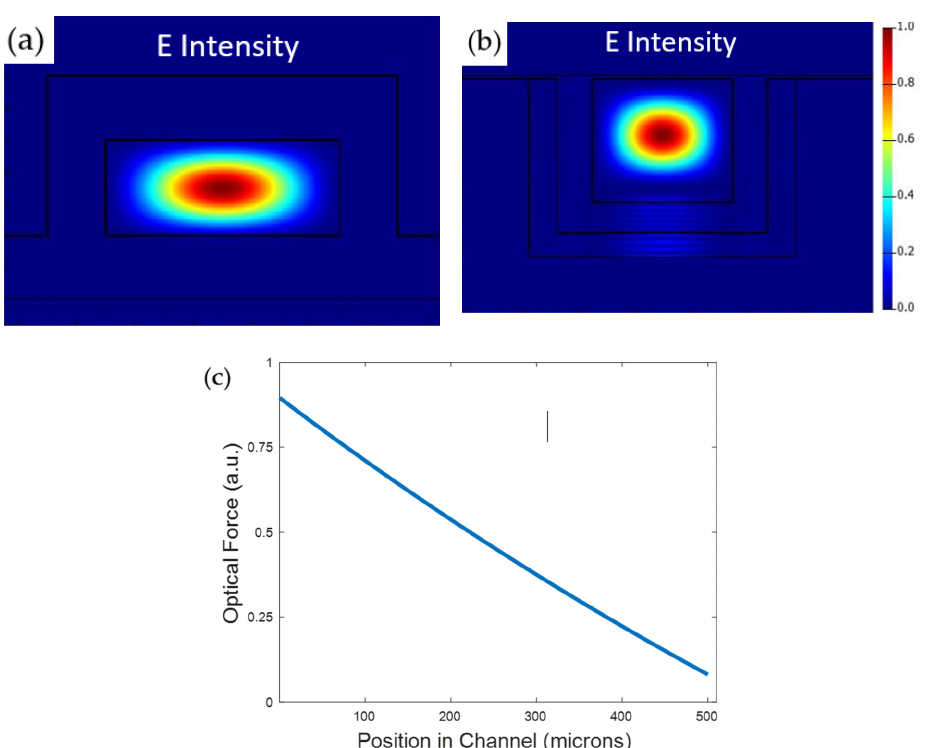
Figure 9. Simulated zero-order E field intensity mode profile for the SC ( a ) and LC ( b ) regions of the platform. ( c ) Simulated optical force spatial distribution. The optical force loss decrease is insignificant for proximity applications.